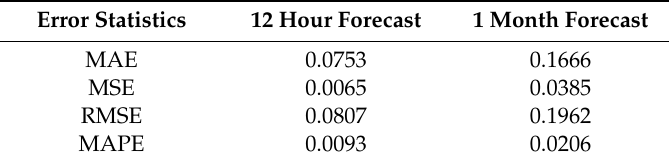
Table 1. Error Statistics for Short-term and Long-term DO Content Forecasting.